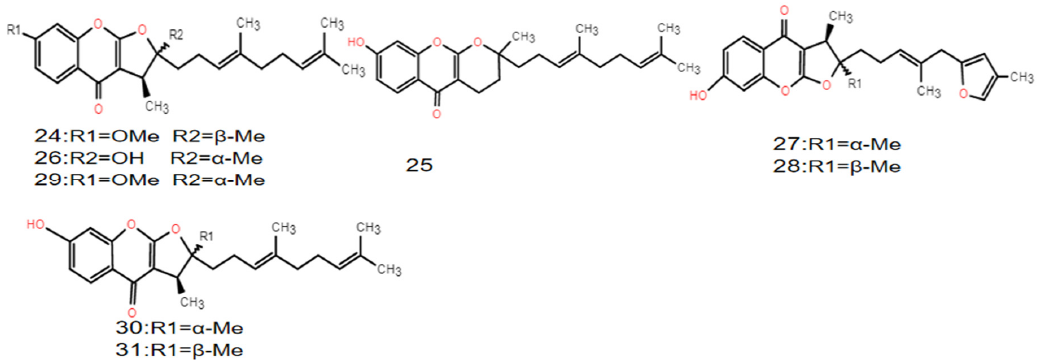
Figure 2. Structural diagram of sesquiterpene–heteroketone compounds of F. ferulaeoides .